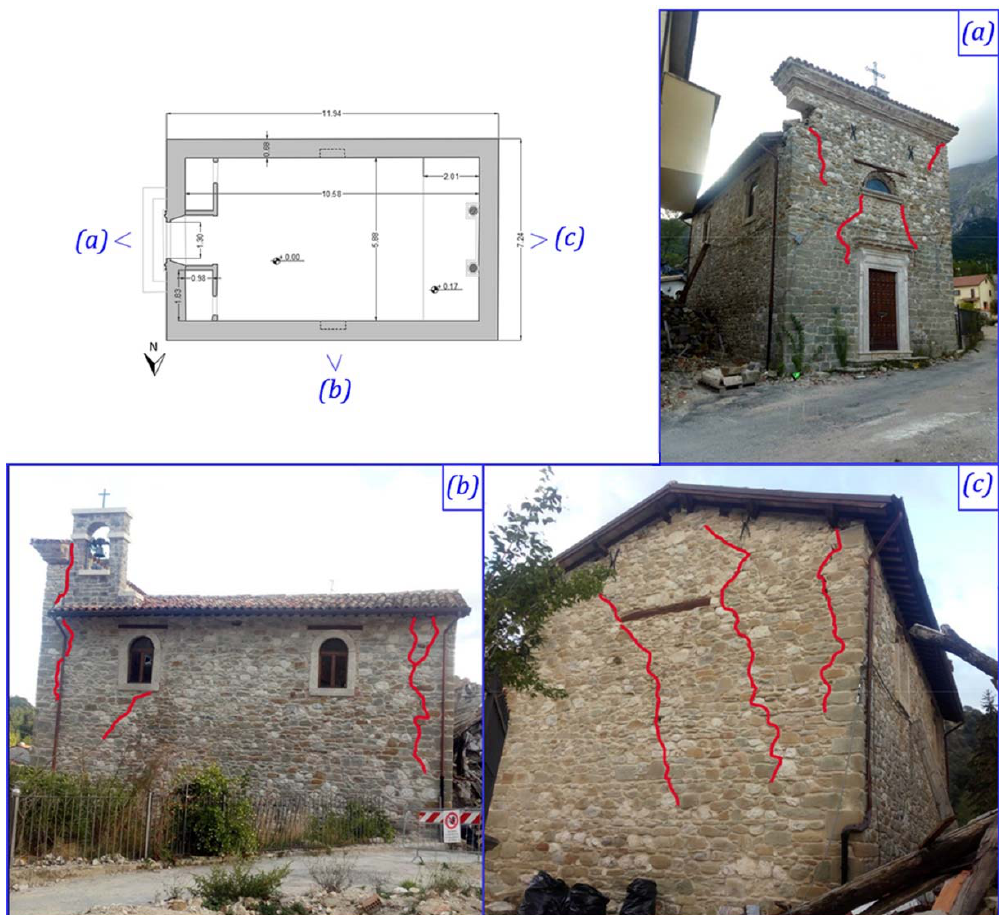
Figure 4. The crack pattern of the Santissimo Crocifisso Church in Pretare (Arquata del Tronto, AP) after the earthquakes of 2016 on ( a ) the main façade and the ( b ) north and ( c ) west facades.